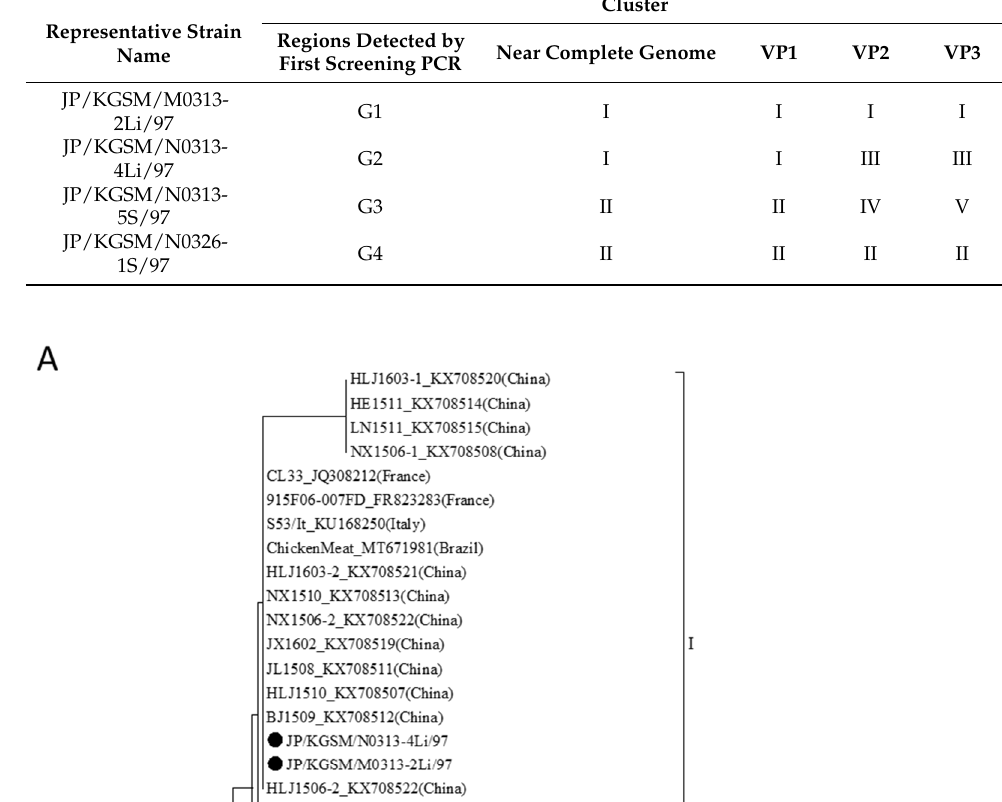
Table 4. Summary of classification based on different genetic regions.